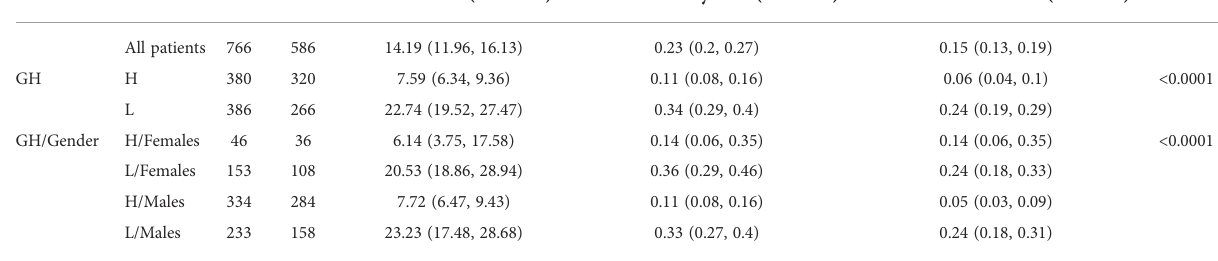
TABLE 3 Log rank test to compare OS between HCC patients with high vs. low GH levels *.